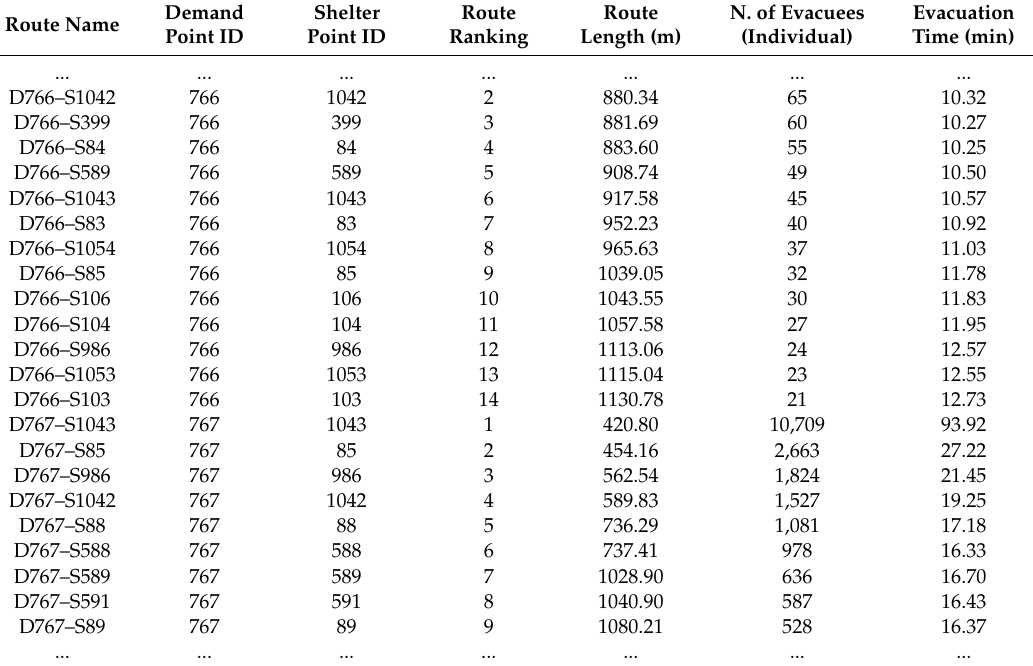
Table 5. The number (N.) of evacuees along each route and the evacuation time required.